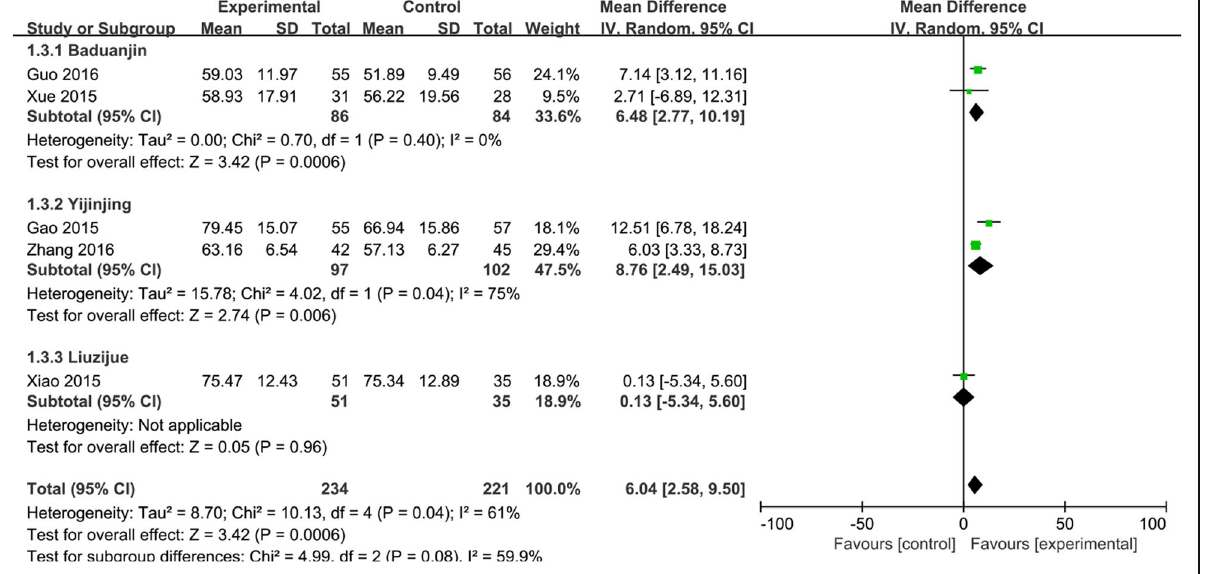
Fig. 5 Effects of Qigong on the forced vital capacity rate of 1 s (FEV1/pre). Subgroup meta-analysis was used to assess the effects of different types of Qigong on the FEV1/pre with a random effects